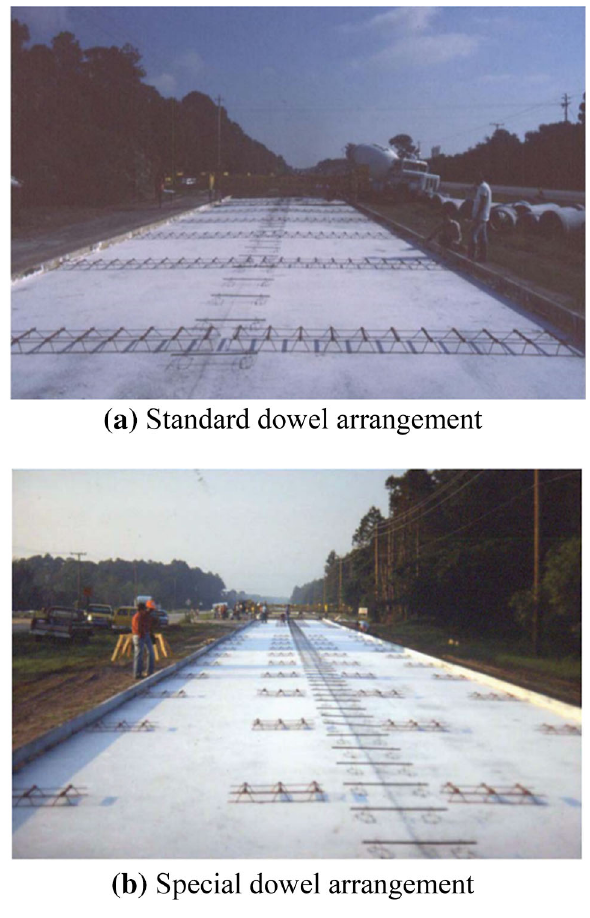
Fig. 5 Dowel arrangements used for project